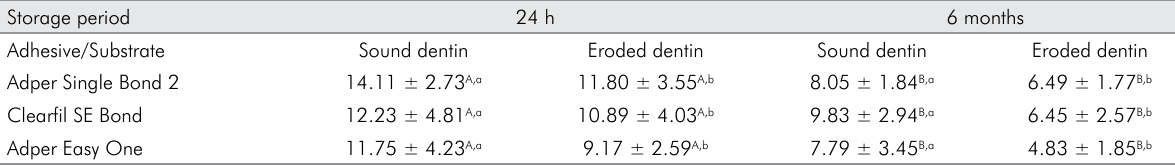
Table 2. µ SBS (MPa) means and standard deviations for all experimental groups (*). Storage period